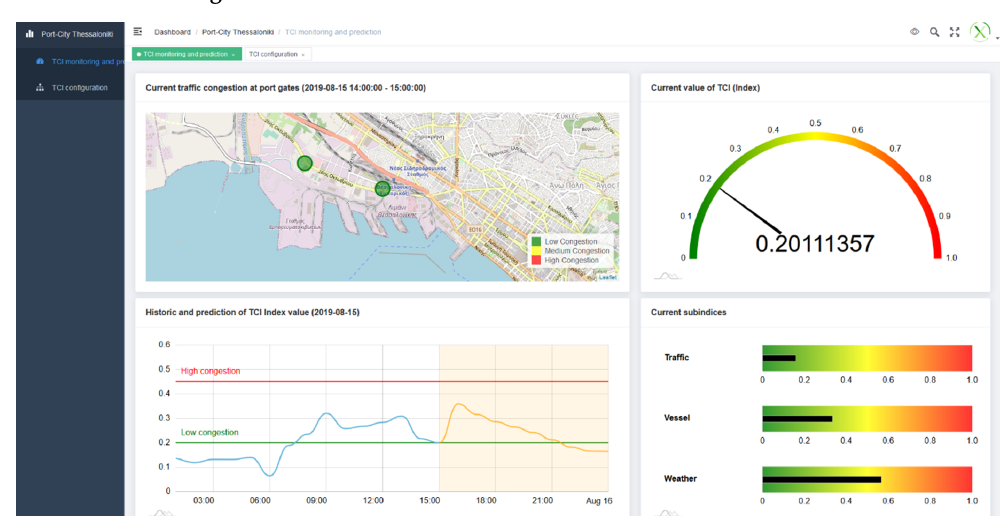
Figure A8. Visualization of the scenario 2.2 in the UI dashboard.